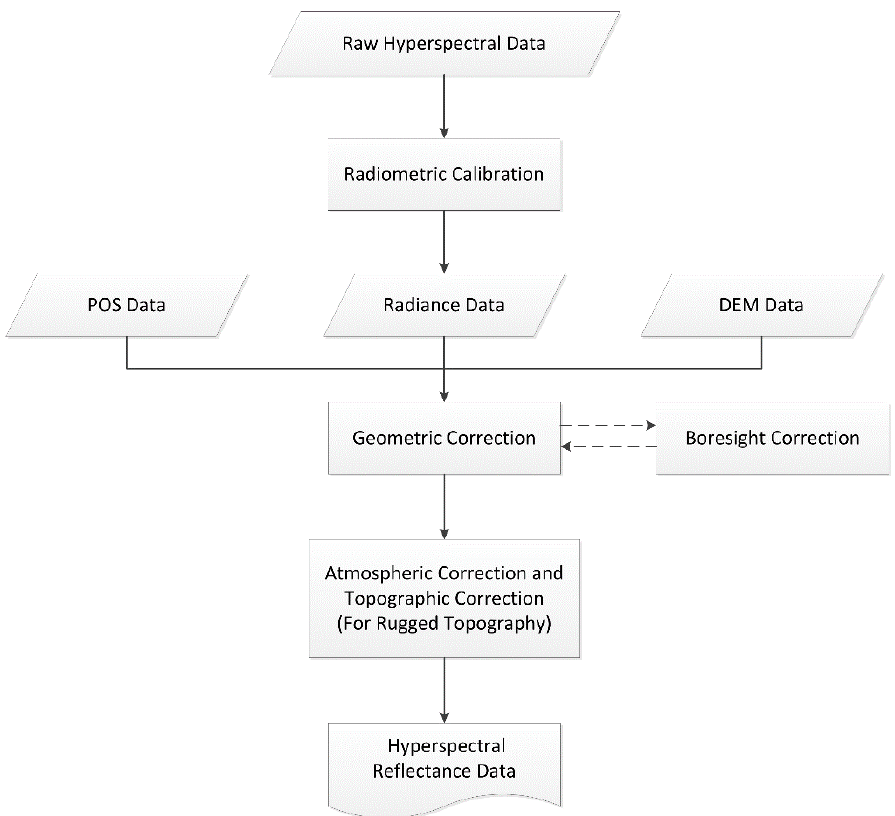
Figure 6. The workflow of hyperspectral data processing.